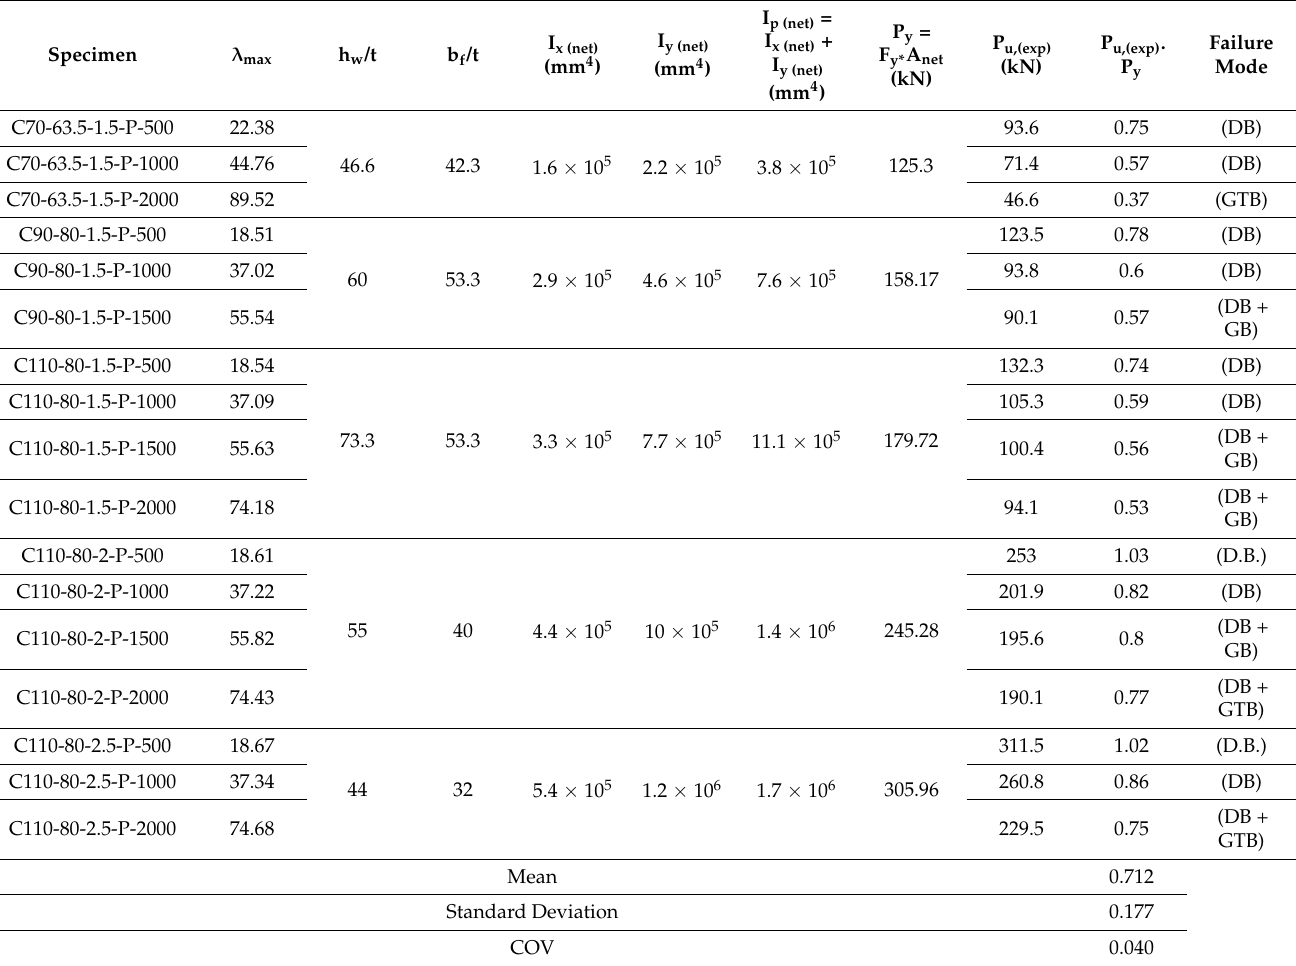
Table 3. Ultimate loads, normalized strength, and failure modes.